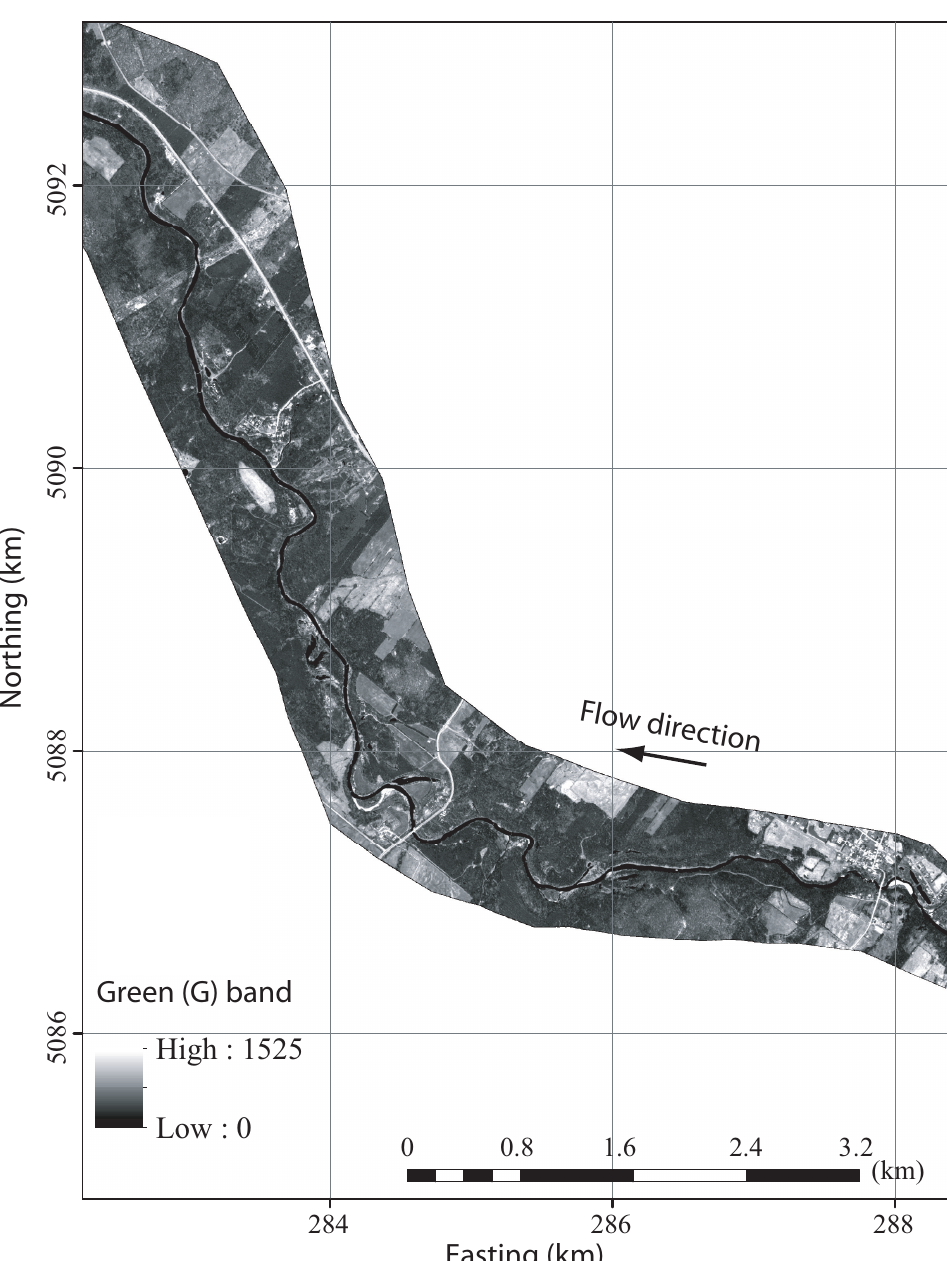
Figure A2. Values of the digital number N (or pixel values) in the green (G) band (Table